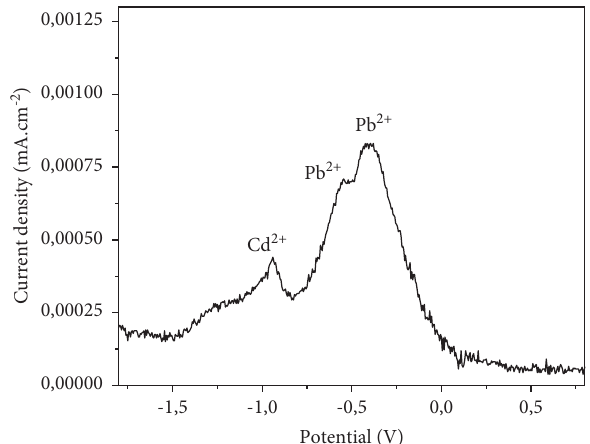
Figure 9: Ionic interference effect by SWV (Hg/Hg 0.1M of Na 2 SO 4